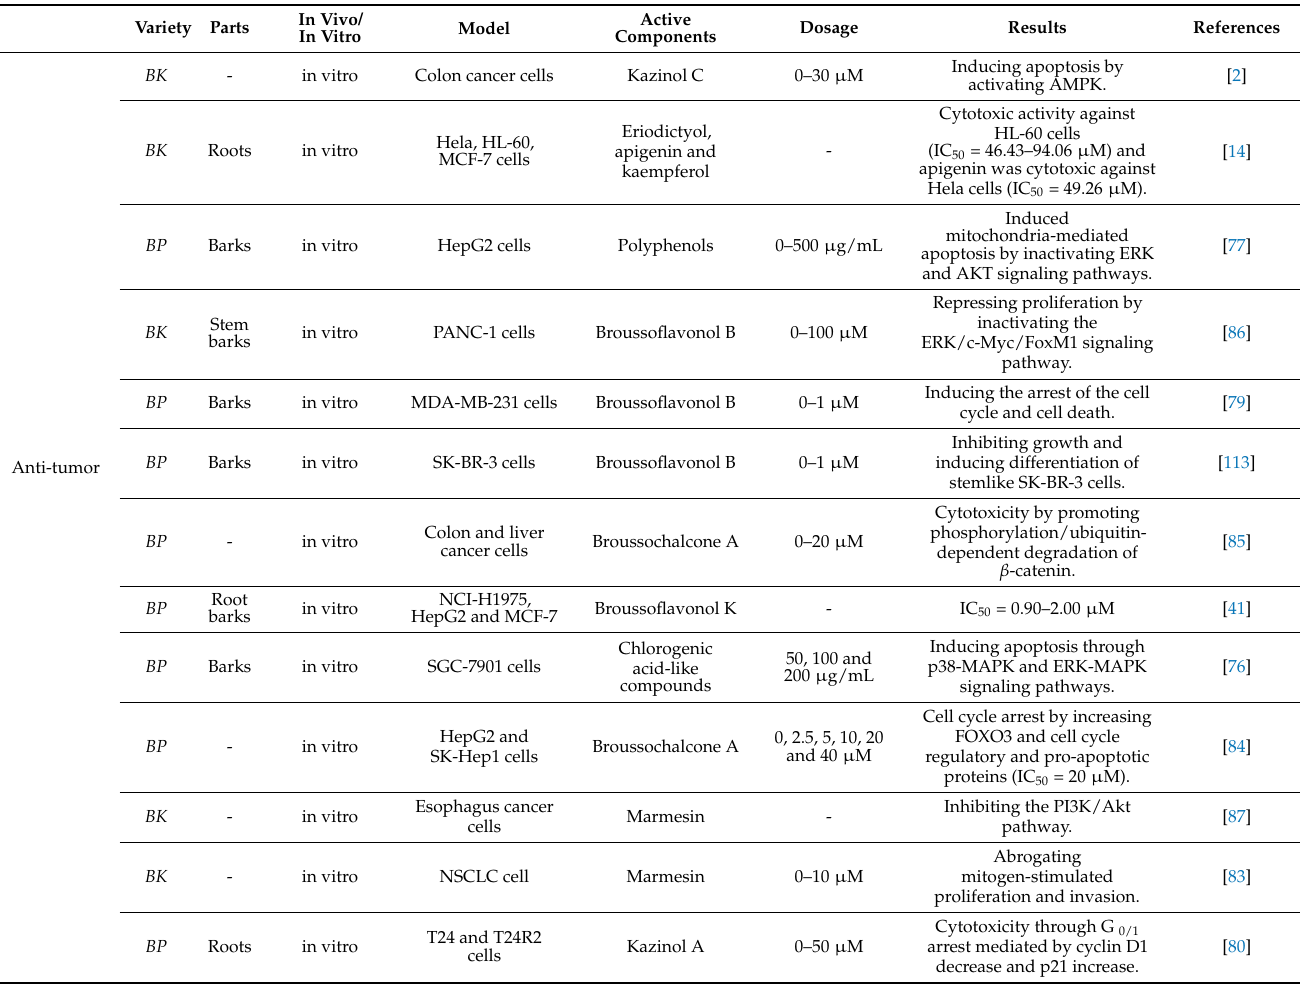
Table 8. Pharmacological effects of Broussonetia